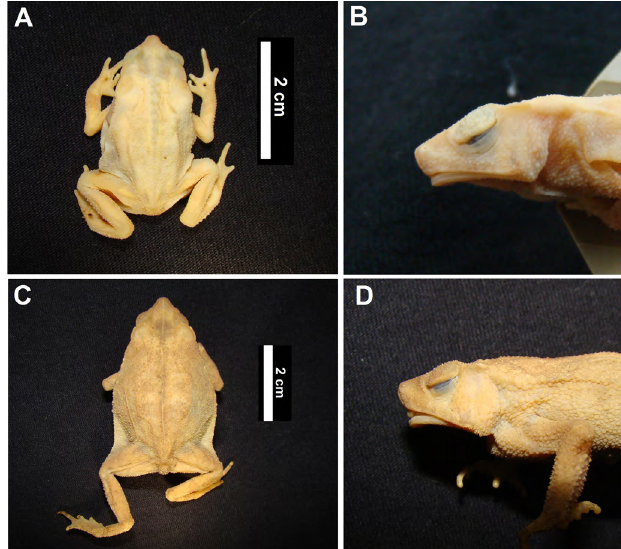
Figure 1. Rhinella scitula collected in UFMS research station, municipality of Corumbá, Mato Grosso do Sul state, Brazil. A) Dorsal view of ZUFMS AMP 1579. B) Snout of ZUFMS AMP 1579 in lateral view. C) Dorsal view of ZUFMS AMP 2621. D) Snout of ZUFMS AMP 2621 in lateral